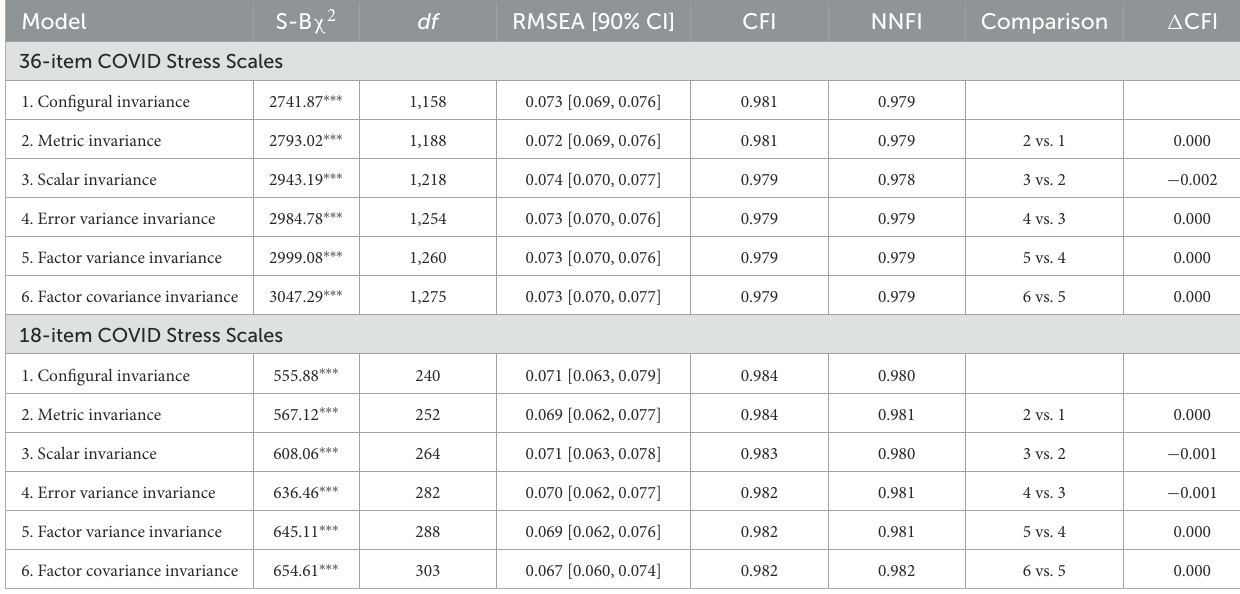
TABLE 3 Invariance across gender.